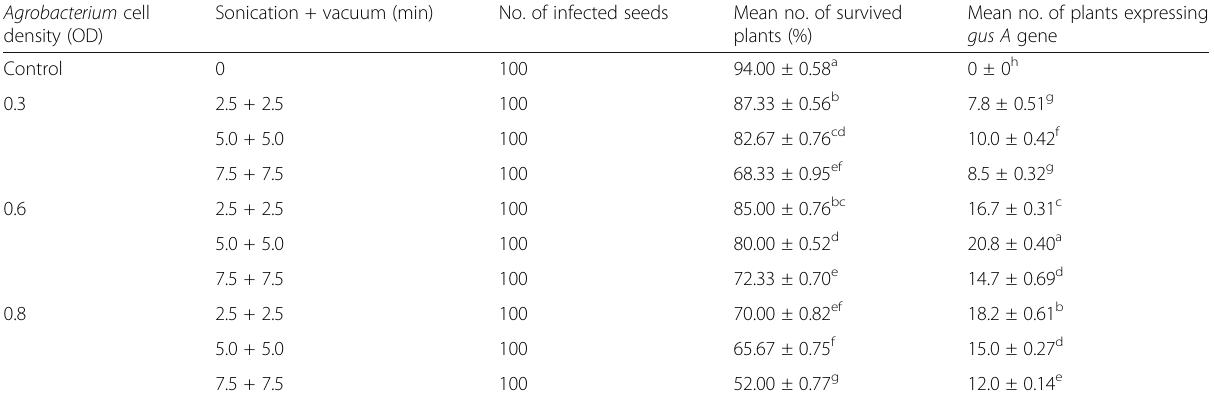
Table 2 Effects of different Agrobacterium culture densities and duration of sonication + vacuum infiltration on the survival rate and gus A gene expression in horse